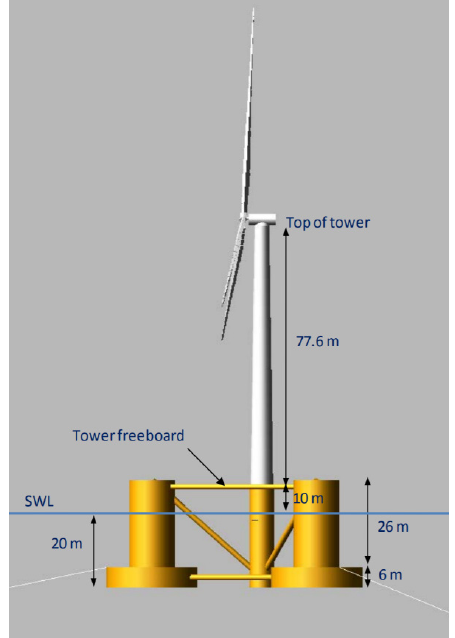
Figure 5. Floating wind system design with OC4 semi ‐ submersible platform [19]. Table 2. Properties selected for the NREL 5 ‐ MW baseline wind turbine (source from: [14]).